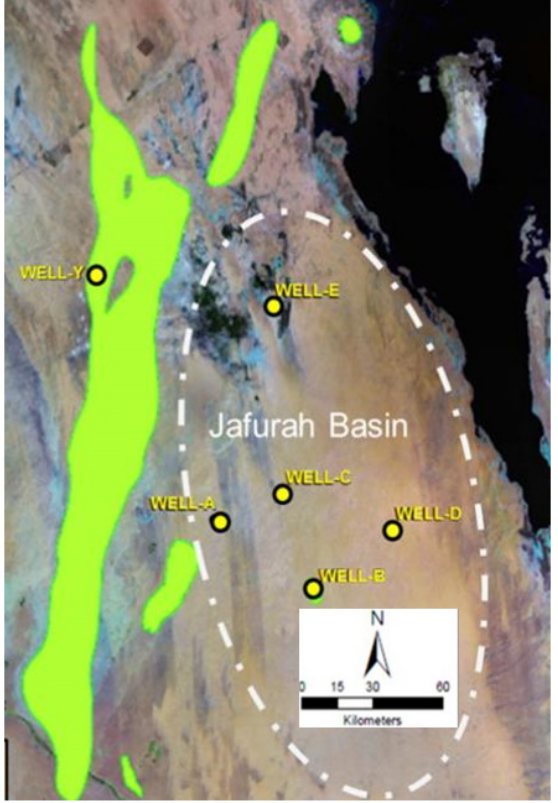
Figure 1. Outline of the Jafurah Condensate Basin (dashed ellipse), with five early exploration wells marked (Wells A–E), and major Ghawar oil field (green). Well Y was used for facies correlation. Modified from Hakami [12].